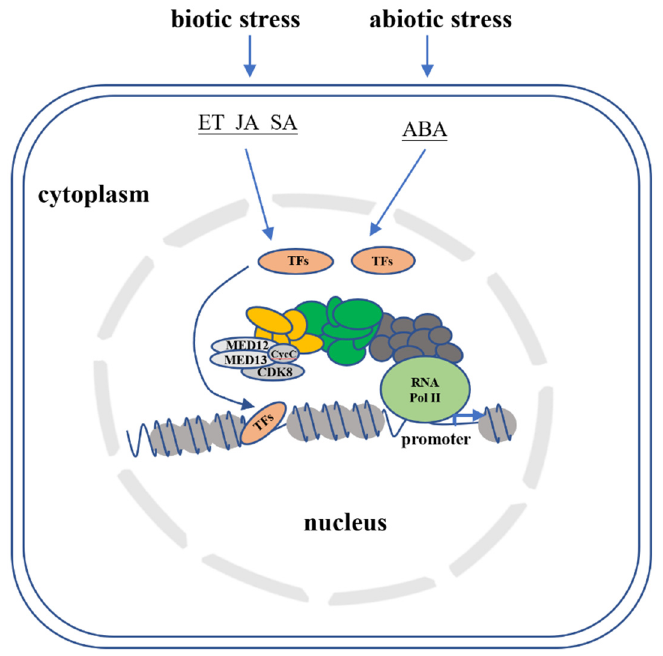
Figure 1. The regulatory functions of Mediator complex in biotic and abiotic stress responses. Biotic and abiotic stresses trigger the plant hormones of ethylene (ET), jasmonic acid (JA), salicylic acid (SA) and abscisic acid (ABA) to activate signaling transduction pathway. A number of transcription factors (TFs) transmit these messages to the transcriptional machinery in the nucleus. Mediator complex functions as a bridge between TFs and RNA polymerase II to precisely regulate the transcription of stress responsive